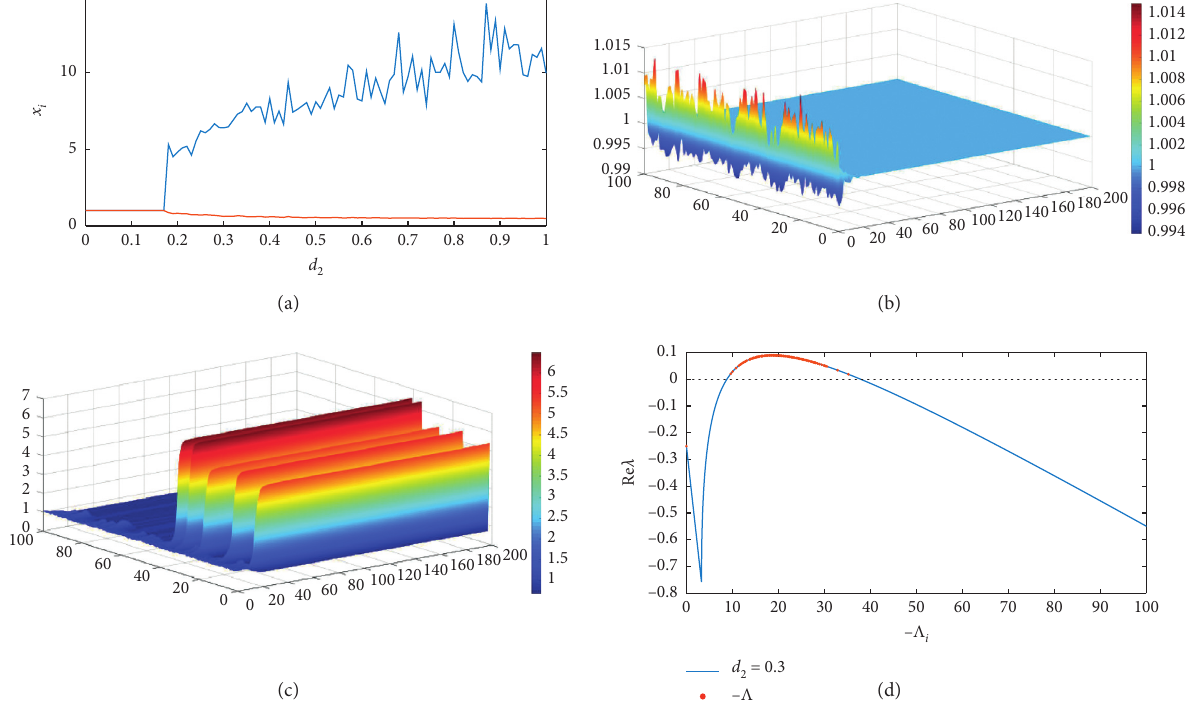
Figure 9: (a) The bifurcation diagram of d � 0 . 1. (c) Turing instability occurs when d d 2 system.